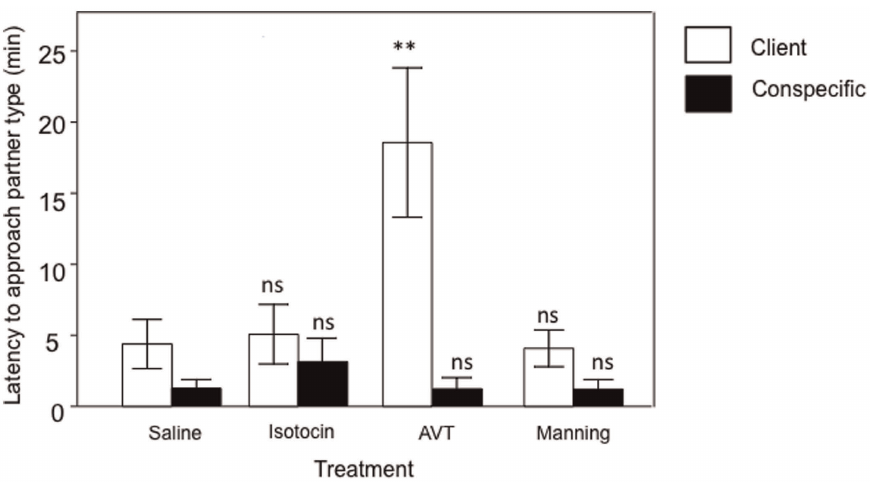
Figure 4. Neuropeptide effect on cleaner fish Labroidesdimidiatus latency in time to approach partner type. Client Zebrazoma desjardiini (white bars) or conspecific (black bars) stimuli. Means are shown 6 1 SEM. Symbols above bars represent P values which refer to planned comparisons of least squares means effect of each neuropeptide treatment group against the reference (saline) group ( ** , , 0.01; ns, . 0.05). Sample sizes were n=8 per group.